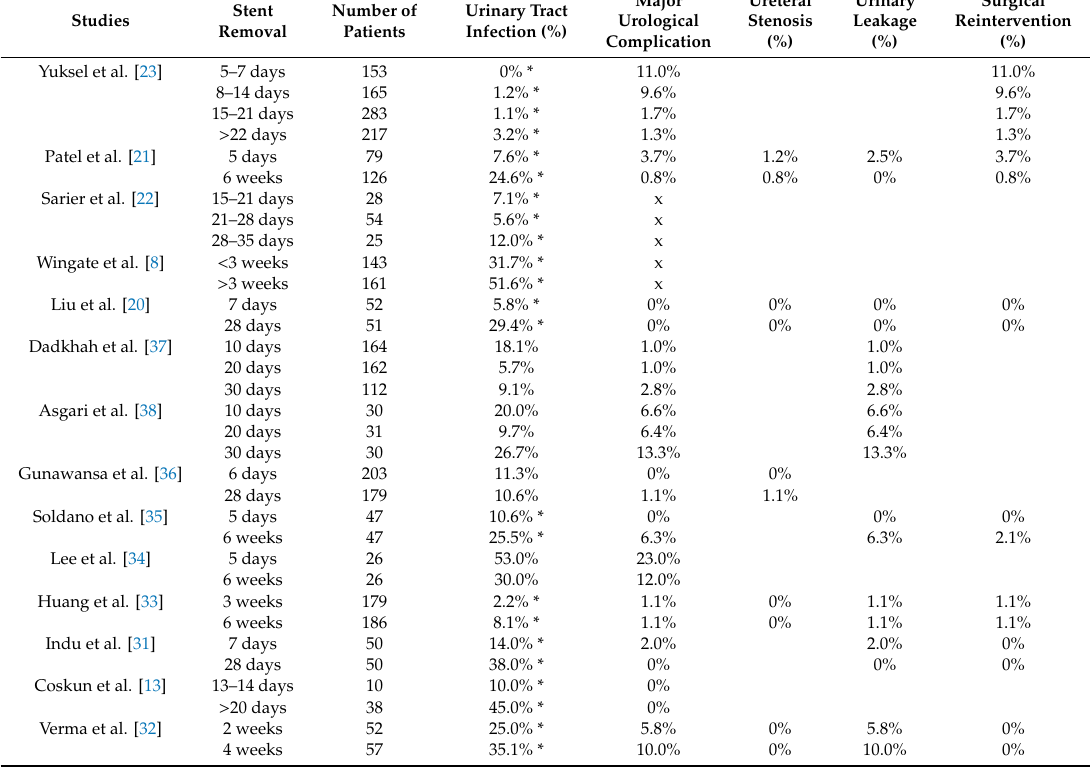
Table 2. Overview of the measured outcome parameters.